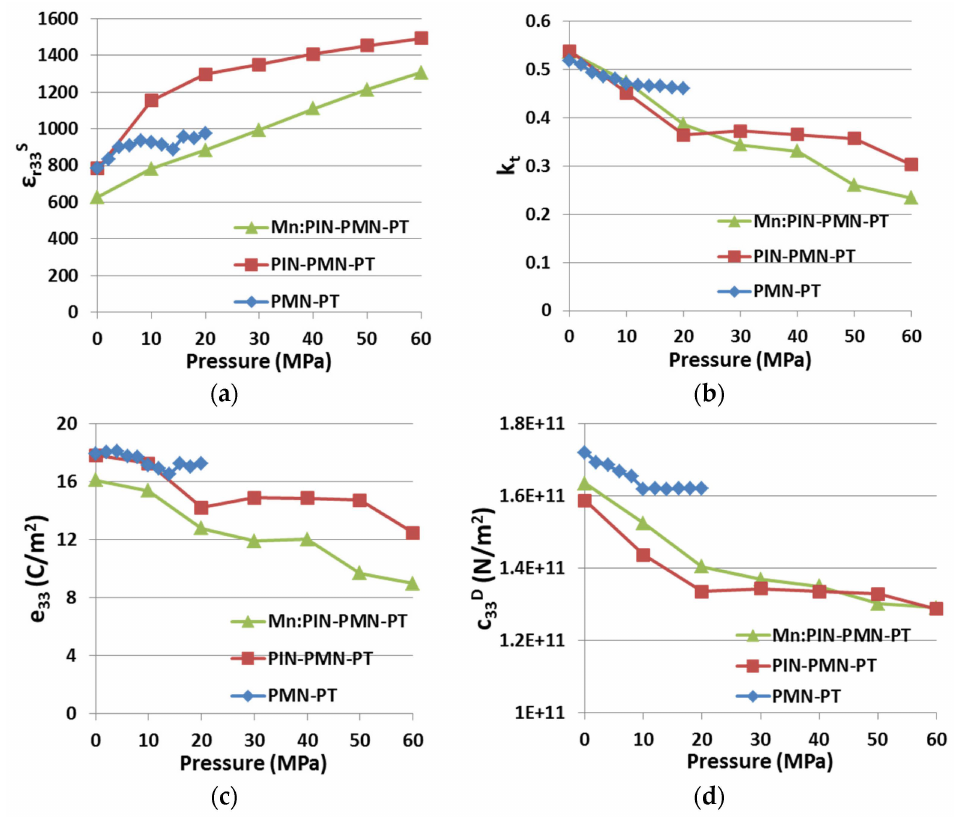
Figure 5. Effect of P on three generations of piezocrystals ( a ) ε r 33 S ; ( b ) k t ; ( c ) e 33 ; and ( d ) c 33 D . (PMN-PT results adapted from